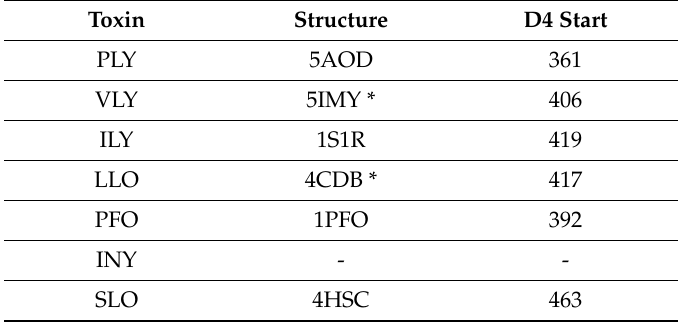
Table 4. The structures of cytolysins used for domain 4 (D4) surface